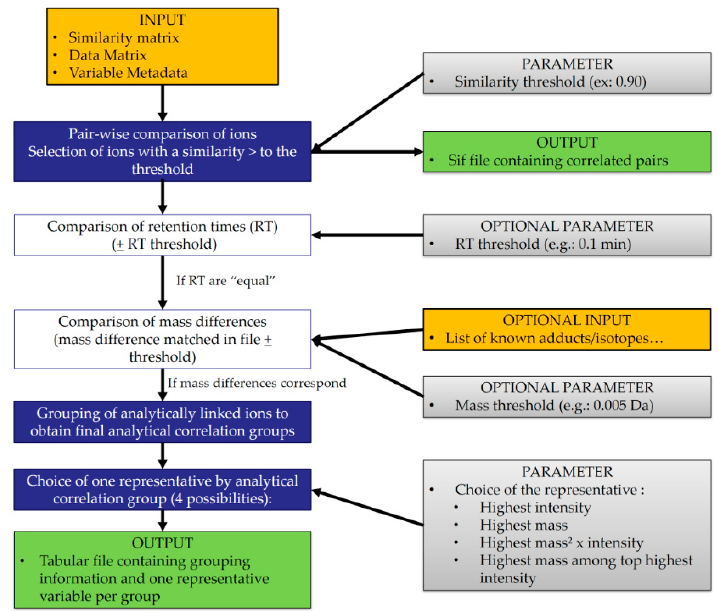
Figure 1. Flowchart representing the major steps of the algorithm (input and output files, parameters, and calculation steps). The key mandatory steps are filled in blue, while optional ones are in white.